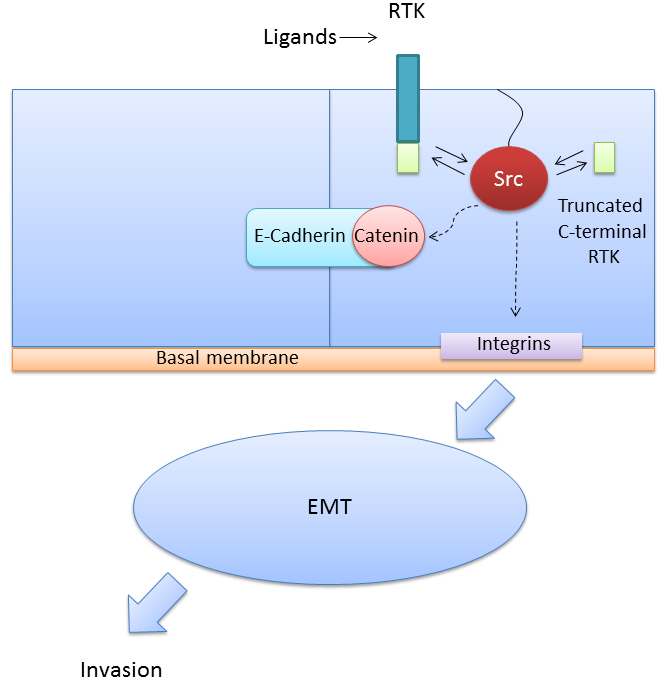
Figure 4. Src signaling pathways and function. Binding of ligands to the corresponding transmembrane tyrosine kinase receptors (RTK) or intracellular truncated C-terminal isoforms of RTKs can activate Src. Activation of Src is involved in different signaling